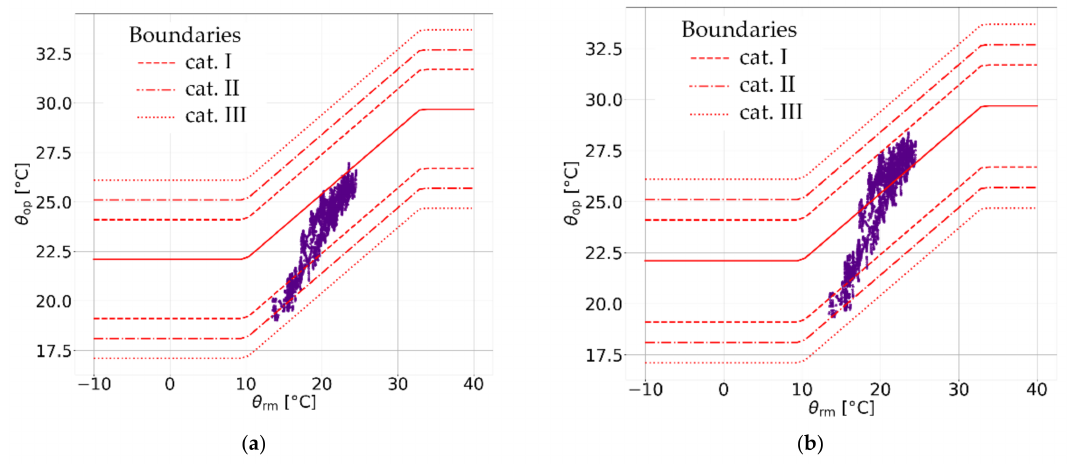
Figure 11. Distribution of datapoints in adaptive comfort categories for ( a ) worst and ( b ) best free-running summer modes in Torre Pellice. Dashed and dotted lines represent adaptive comfort categories’